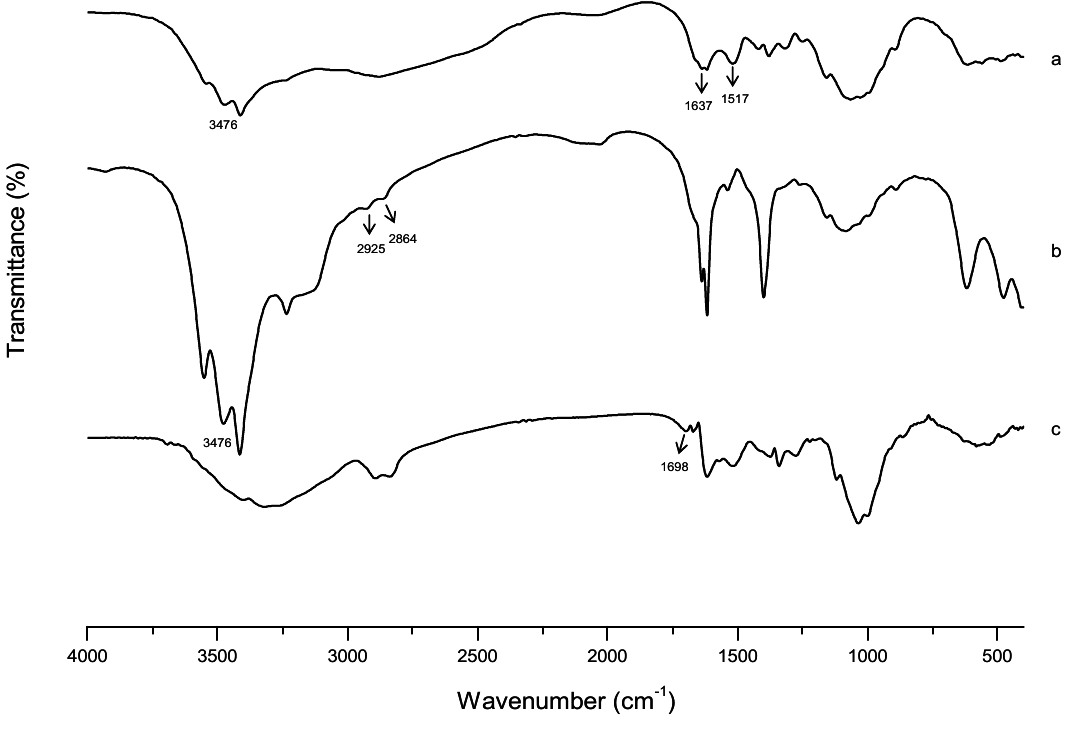
Figure 3. FTIR spectra of ( a ) CS, ( b ) CS-DA and ( c ) FA-CS-DA.